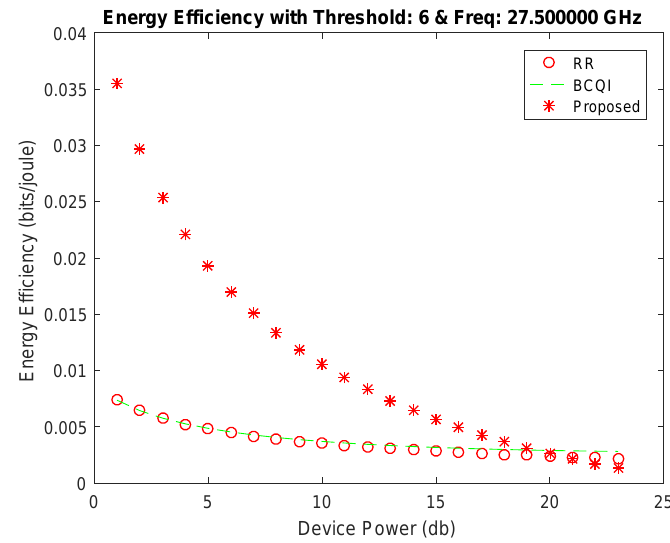
Figure 4. Energy efficiency achieved at threshold